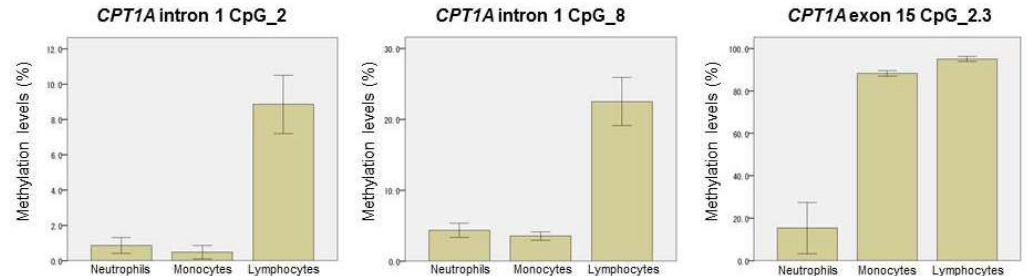
Figure 3. Cell-type-specific methylation levels. Values are given as the mean ± SD. Freshly isolated blood cells from women (control) ( n = 7) were fractionated using an immunomagnetic negative selection method.